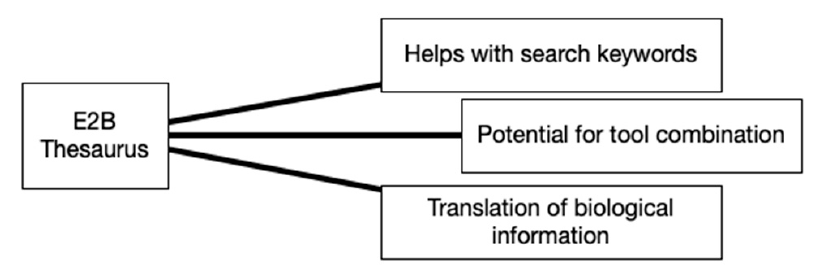
Figure 5. Engineering-to-Biology Thesaurus discussion themes.